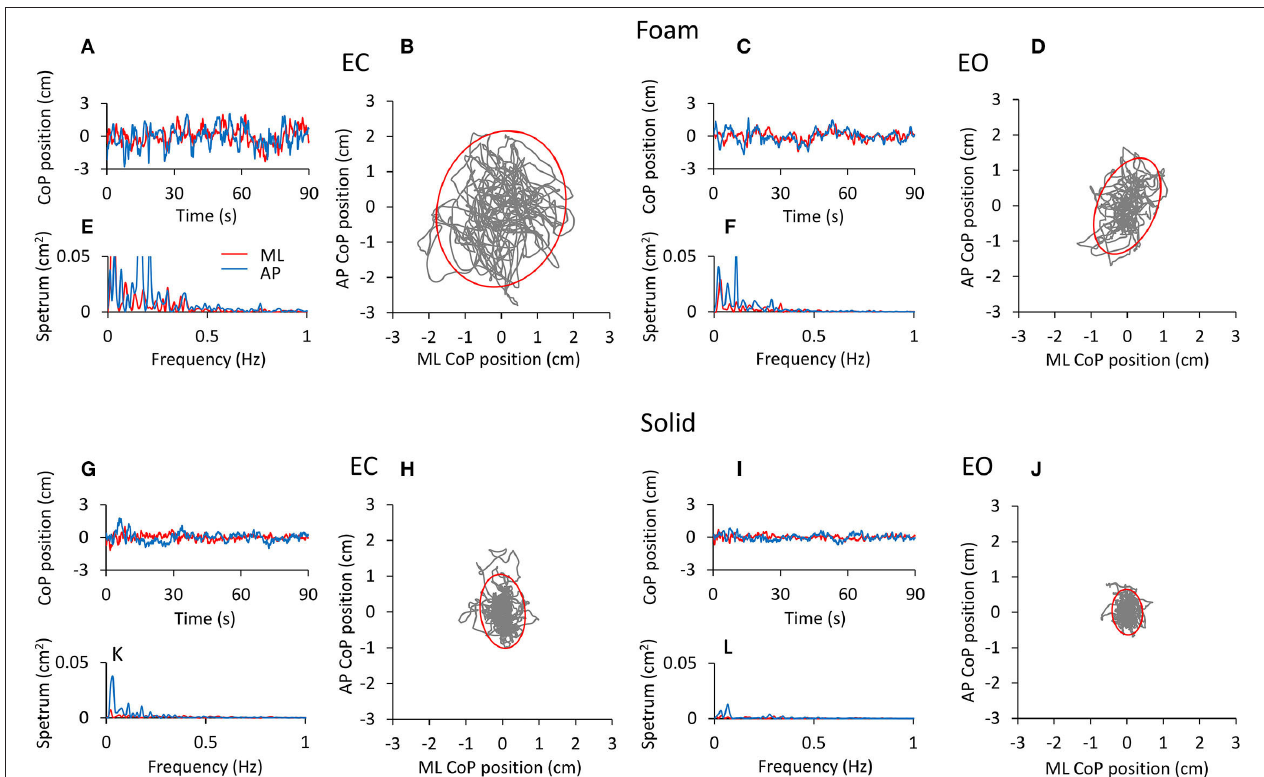
FIGURE 1 | CoP excursion and power spectrum in a representative subject (top panels, Foam; bottom panels, Solid). The CoP excursions along the ML (red traces) and AP (blue traces) directions are reported for the four conditions of interest [ (A) , EC Foam; (C) , EO Foam; (G) , EC Solid; (I) , EO Solid]. The CoP excursions in the horizontal plane and the 95% prediction ellipses are shown for EC (B,H) and EO (D,J) conditions, both with Foam (B,D) and Solid (H,J) supports. The corresponding power spectra are reported in (E,F,K,L) for both ML (red) and AP (blue) directions.